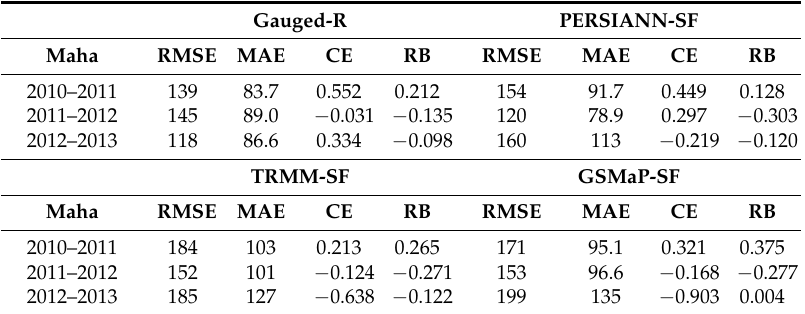
Table 5. Evaluated error of the calculated discharge in the Maha seasons, in comparison with the observed discharge.